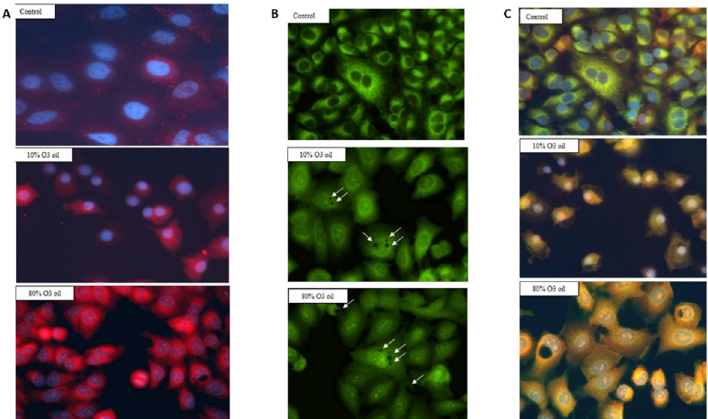
Figure 6. Intracellular calcium release as induced by ozonized oil in A549 lung cancer cells detected by rhodamine staining (red) and fluorescence microscopy. Mitochondrial membranes are labeled by DiOC6 staining (green). Red and green overlap reading both channels at the same time (right columns) indicates that calcium is released from mitochondria (yellow). Nuclei are colored by DAPI staining (blue).